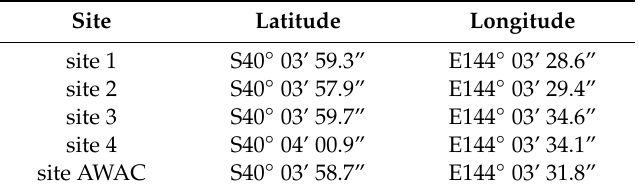
Table 1. Coordinates of center location for each coring